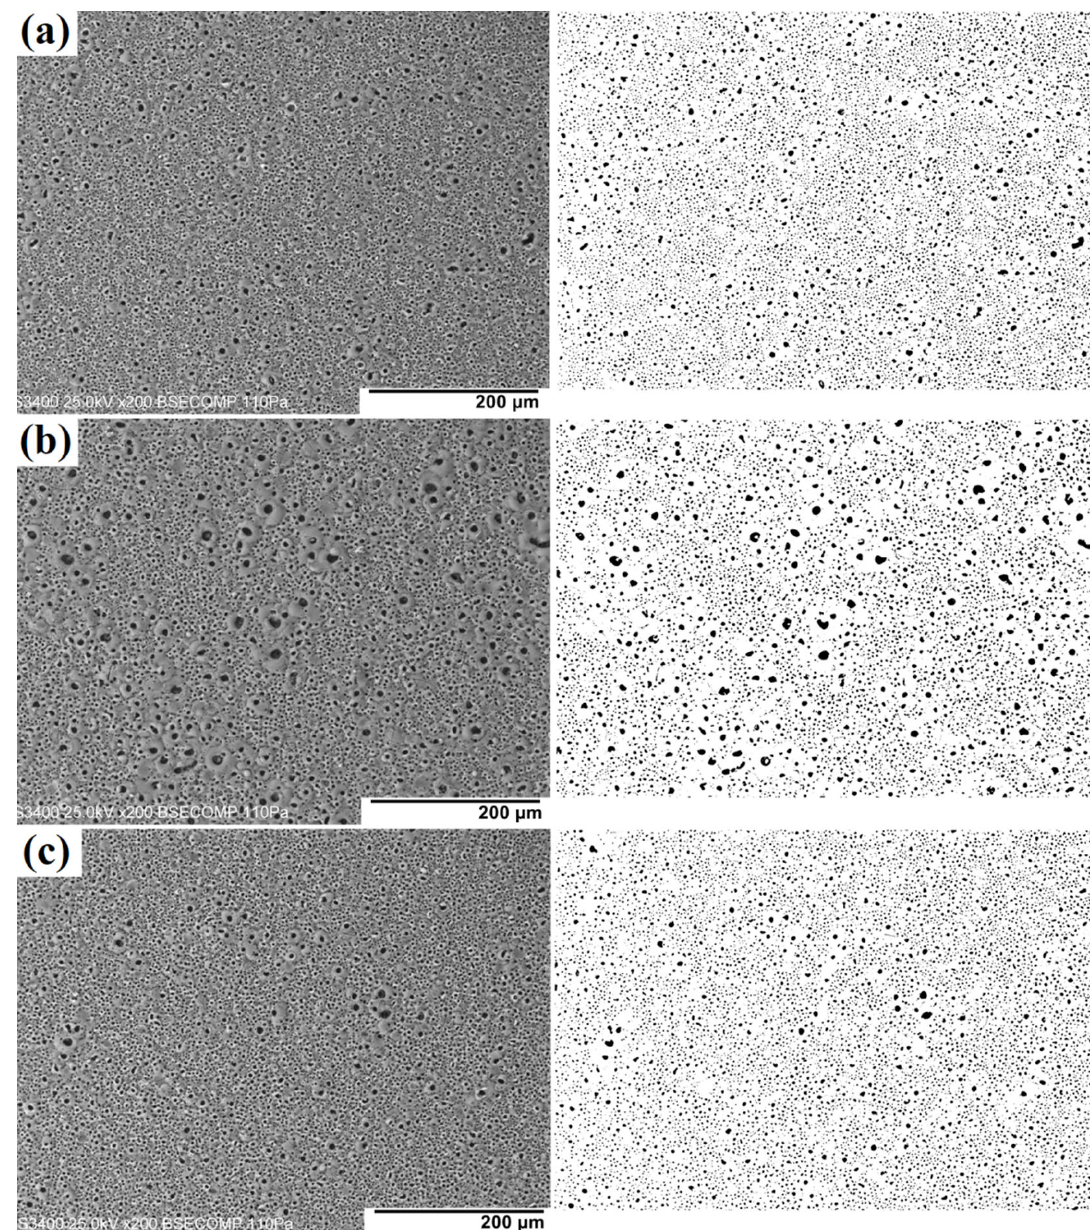
Figure 2. SEM surface morphology and binary analyzed images of the PEO coatings: ( a ) Base; ( b ) BF4; ( c ) F.